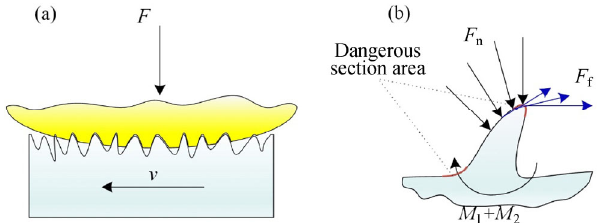
Fig. 13 Schematic diagram of the force decomposition for friction on a rough